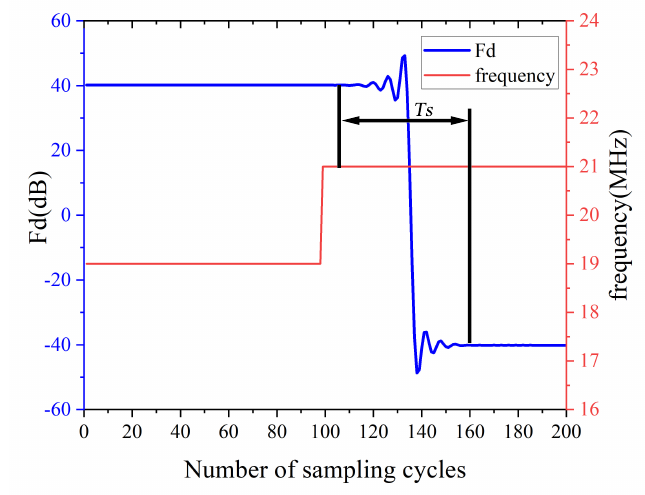
Figure 10. Changes in the output of the frequency real − time calculation module when the frequency suddenly changes.